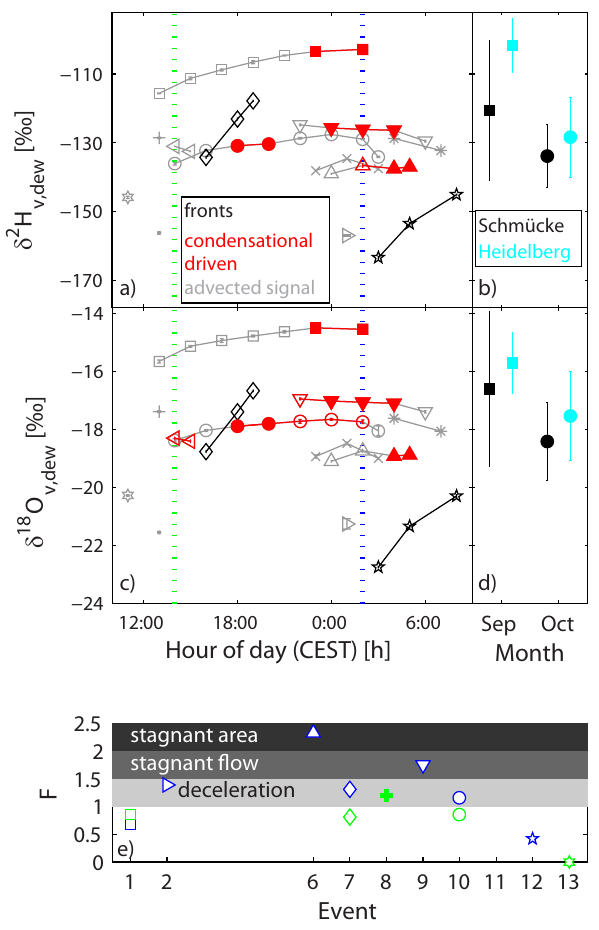
Fig. 5. δ values of the water vapor at dew point temperature cal- culated with model run A (Eq. 7) from the measured cloud water samples for δ 2 H (a) and (b) and δ 18 O (c) and (d) . Black symbols indicate high gradients in δ values in water vapor and liquid wa- ter samples, which could be associated to fronts. The measurements explainable by local condensational effects according to the criteria specified in Sect. 2.4 (using model run B) are plotted as filled red symbols. For open symbols, the condensational criteria were only met for either δ 2 H or δ 18 O. The dotted blue and green vertical lines in panel (a) and (c) indicate the launch time of the meteo soundings in Meiningen (Fig. 1). (e) The Froude number F calculated from the profile data of these launches for the different events character- izes the overflow conditions at the measurement station, including the ranges of the overflow characterization as described in Sect. 2.3. Panels (b) and (d) show the monthly means and their variation for September and October for the equilibrium derived water vapor val- ues at the dew point for Schm¨ucke (black symbols) and for an 8yr data set collected in Heidelberg (cyan symbols; Jacob and Sonntag,